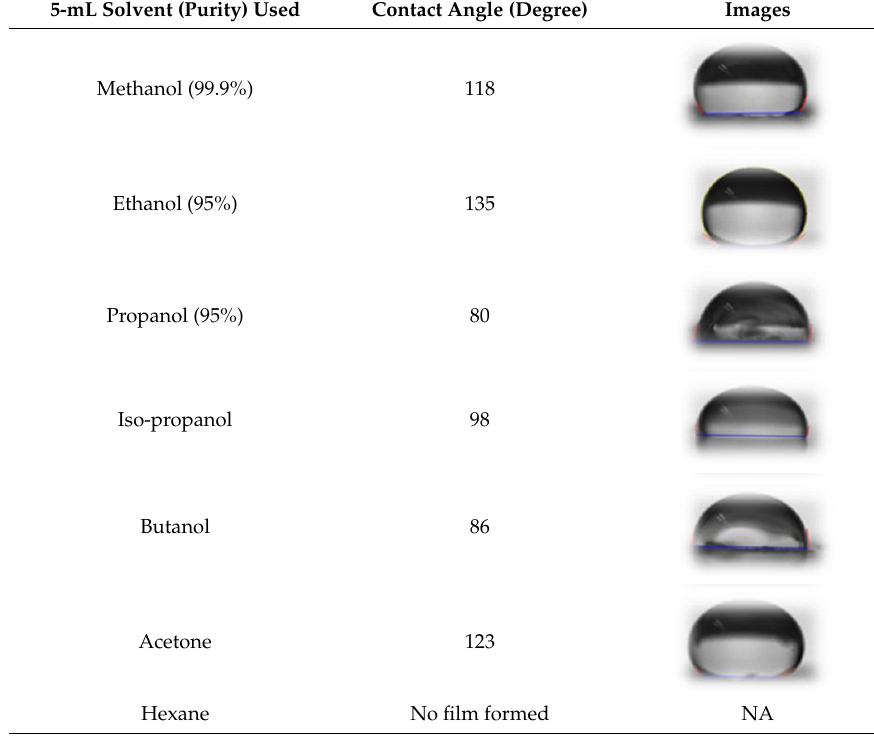
Note: Reaction time = 4 h; NA = not available.